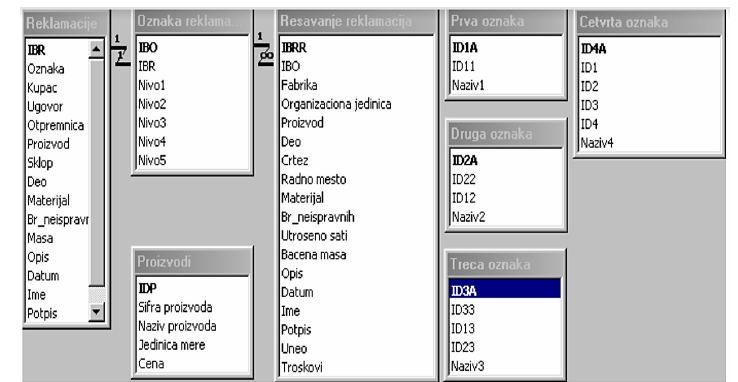
Figure 11 – Example of the window „search for claims on nonconformities” Рис . 11 – Пример окна " поиск претензий по дефектам " Слика 11 – Пример прозора за „ претраживање рекламација неисправности ”